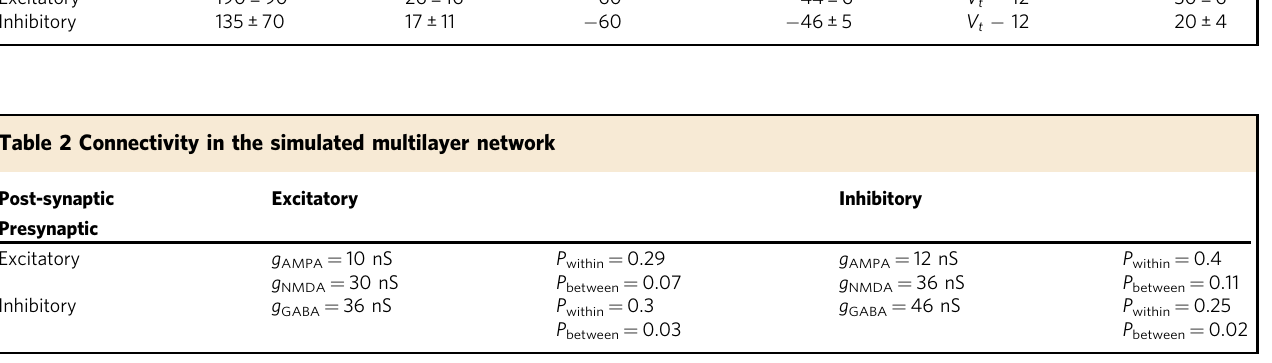
Table 1 Intrinsic parameters of leaky integrate-and- fi re neuronal models Neuron type